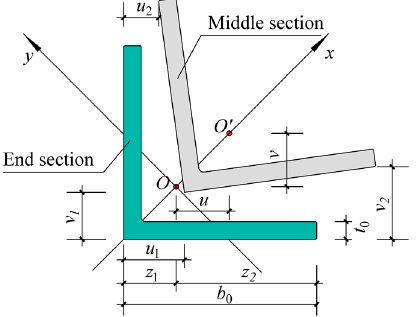
Table 1. Tension coupon test results.